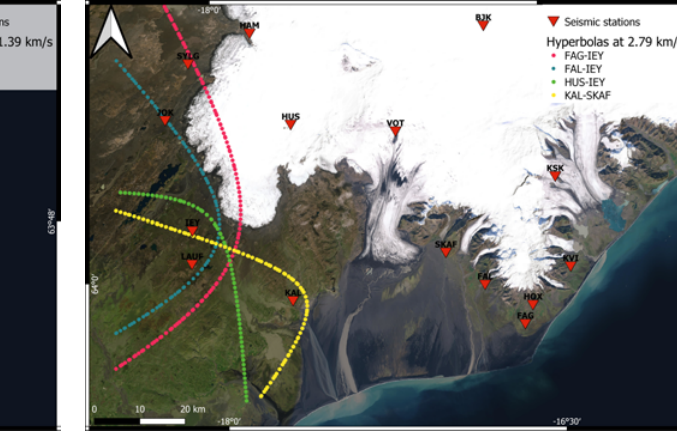
Figure 7: Map showing four hyperbolas for stations FAG, FAL, HUS, IEY, KAL and SKAF for a propagation veloc- ity of 2.79 km s −1 . Lag times are: ´ 20.05 s for FAG-IEY, ´ 19.3 s for FAL-IEY, ´ 8 s for HUS-IEY, and 10.55 s for